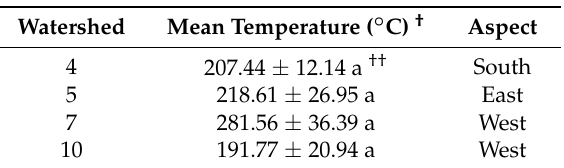
Table 3. Mean ± standard error air temperature at 30 cm above the soil surface for burned watersheds at Trail of Tears State Forest, IL.